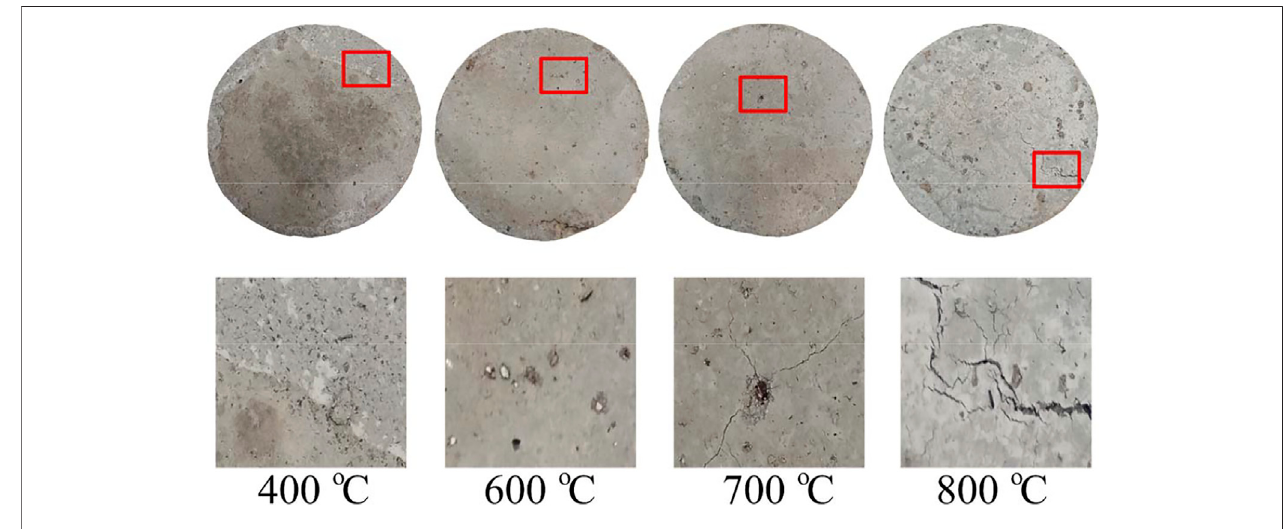
FIGURE 3 | Specimens top view images after heating.